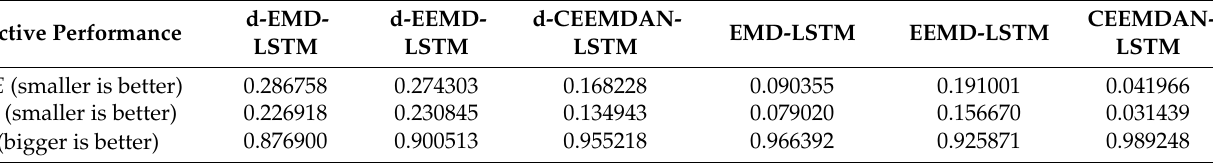
Table 2. Comparison of prediction performance of models with single dataset and hybrid dataset.